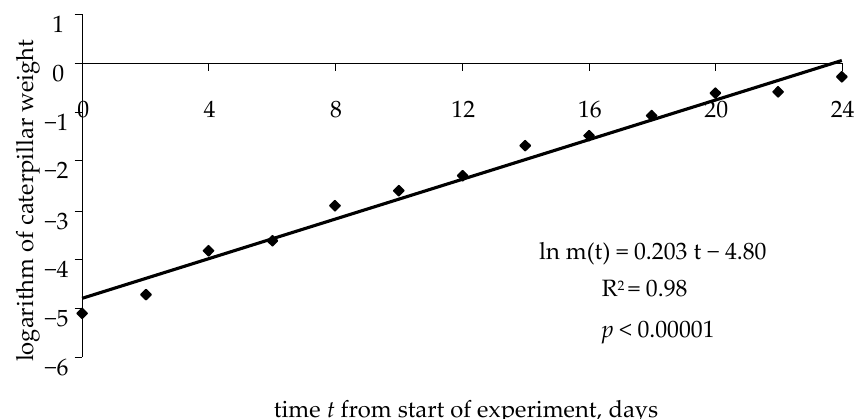
Figure 6. Dynamics of caterpillar weight growth (female No. 11, host plant species: Siberian larch).